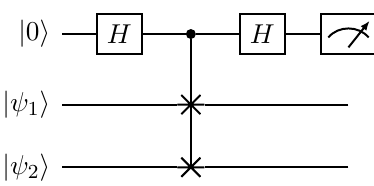
Figure 3. Circuit for the swap test estimating the overlap of | ψ 1 i and | ψ 2 i